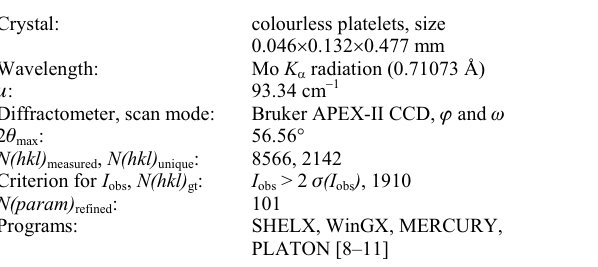
Table 1. Data collection and